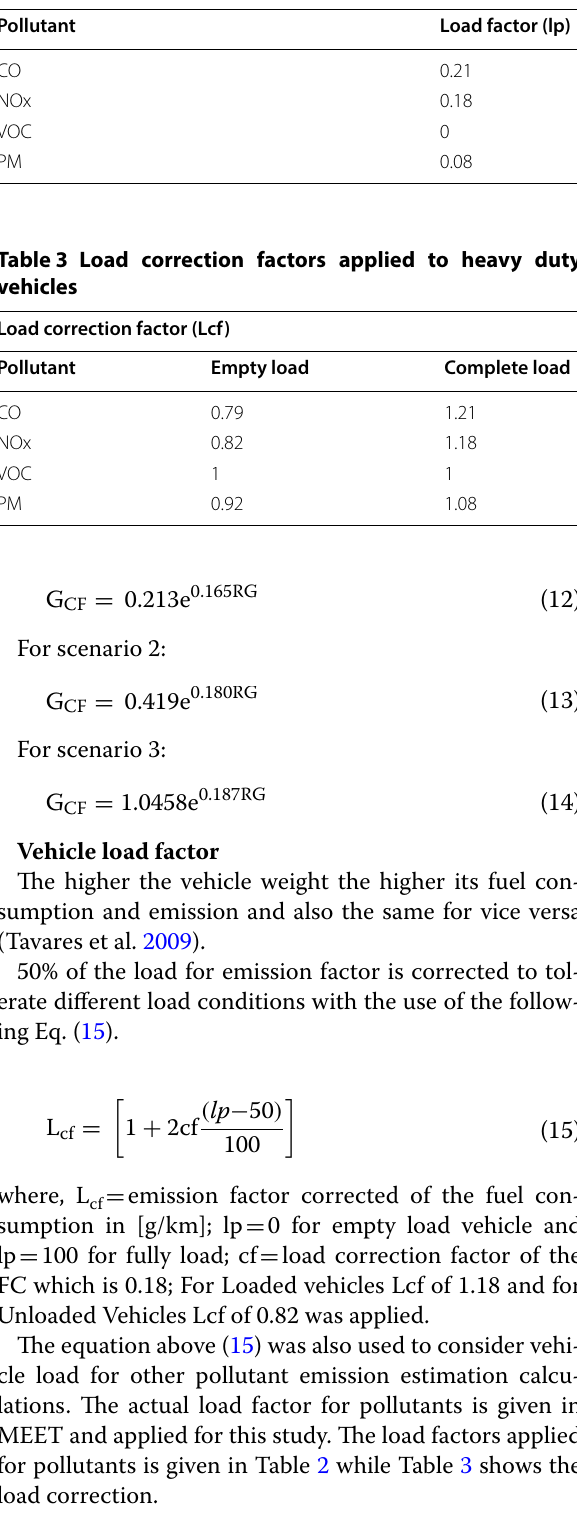
Table 2 Load factors applied to heavy duty vehicles